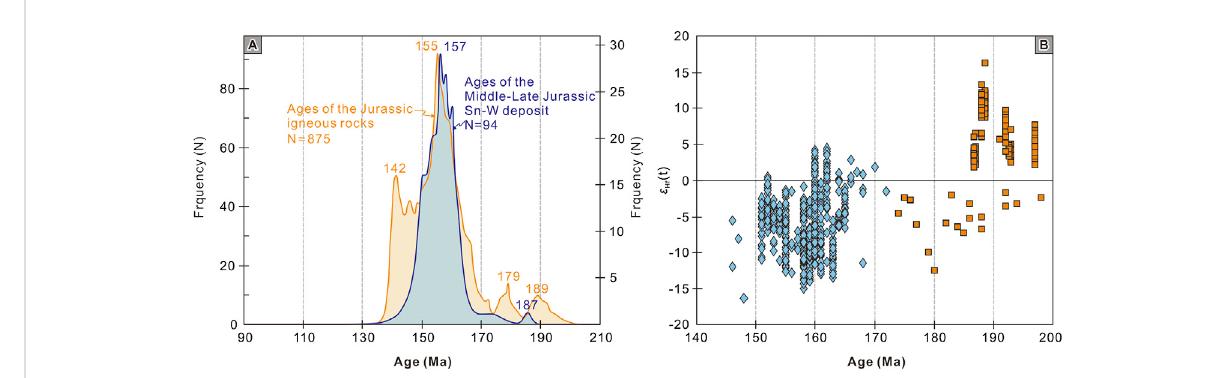
FIGURE 10 (A) HistogramoftheJurassicigneousrocksandSn-WmineralizationinSouthChina.DataarefromCaoetal.,2021;Fengetal.,2019;Maoetal., 2019; Xiao et al., 2019, and references therein. (B) ε Hf (t)-age diagram for zircons from the Jurassic igneous rocks, South China. Data are from Liet al., 2018, Yang et al., 2021, and references therein. The orange square represents the Early Jurassic igneous rocks with ages of 174 – 198 Ma. The slightly blue rhombus represents the Middle-Late Jurassic igneous rocks with ages of 146 – 172